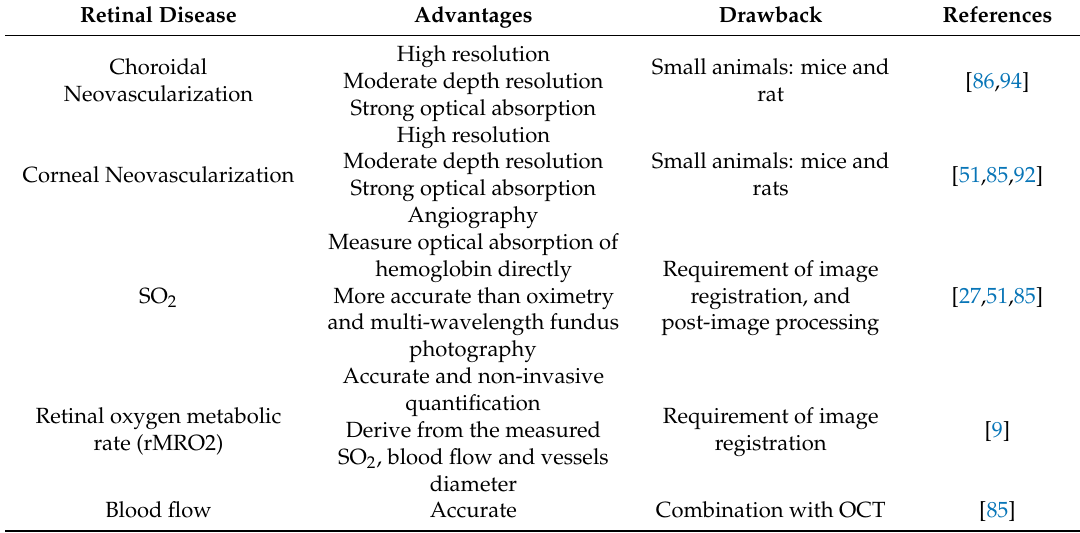
Table 4. Prospects of